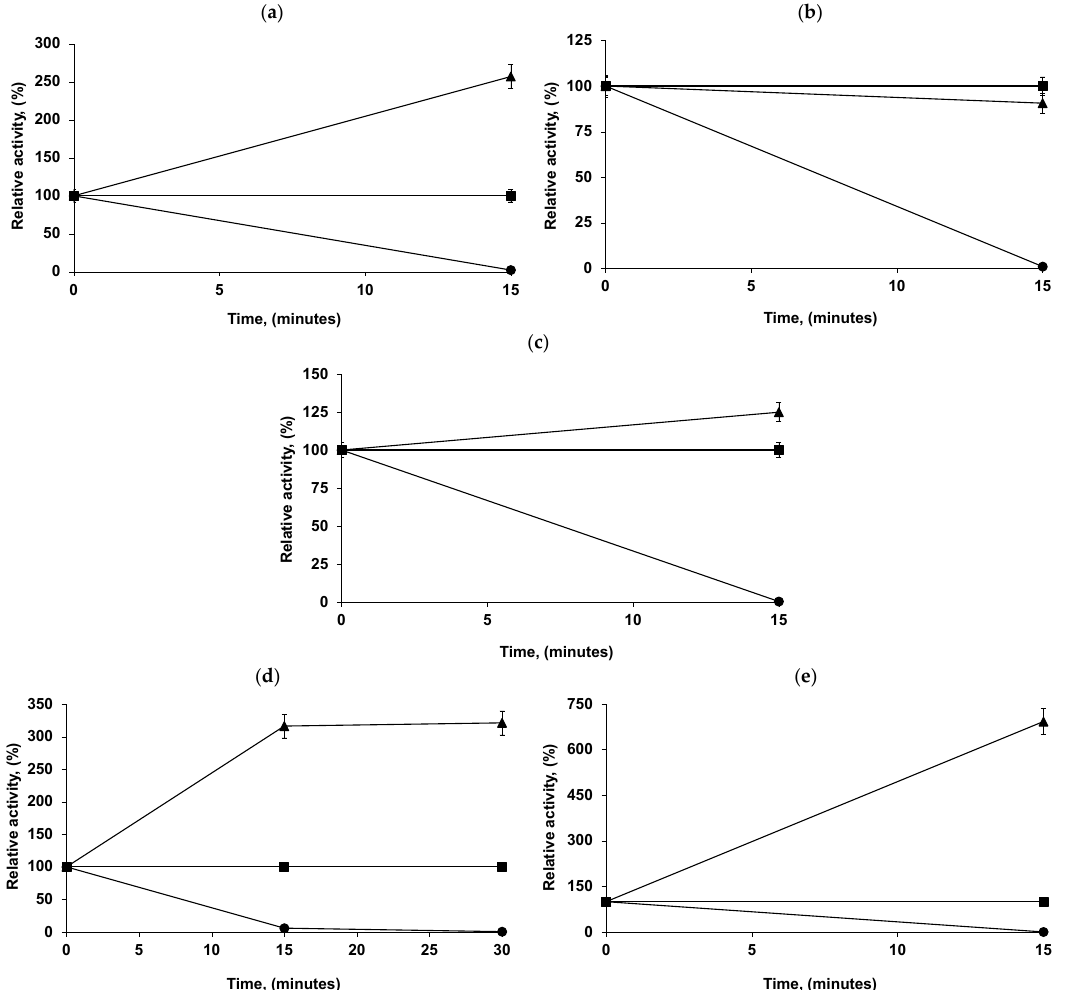
Figure 1. Immobilization courses of different lipases on octyl agarose beads. ( a ) Candida antarctica lipase A (CALA), ( b ) Candida antarctica lipase B (CALB), ( c ) Thermomyces lanuginosus (TLL), ( d ) Lecitase ultra (LEU) and ( e ) Rhizomucor miehei (RML). Solid squares: reference; solid triangles: suspension and solid circles: supernatant. Other specifications are described in Methods.